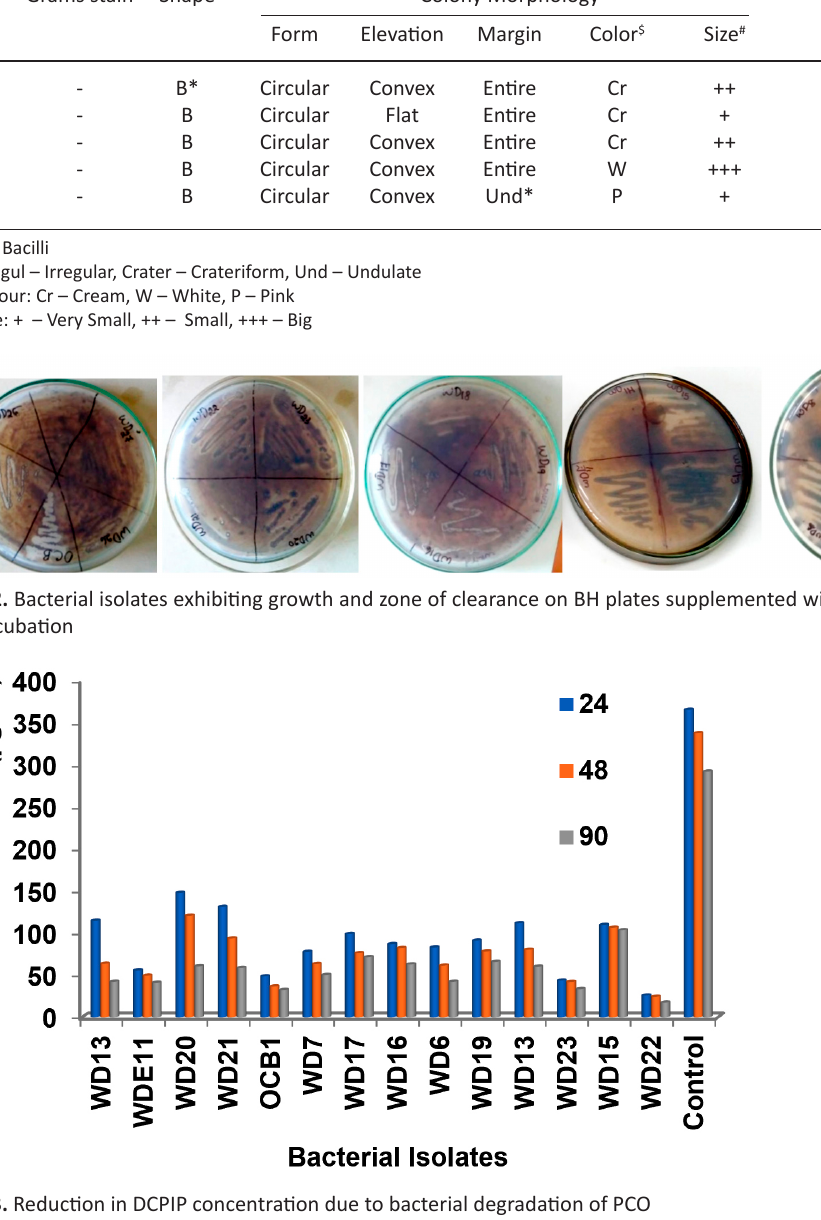
Table 3. Morphological and Colony characteristics of isolates obtained post enrichment in PCO No.